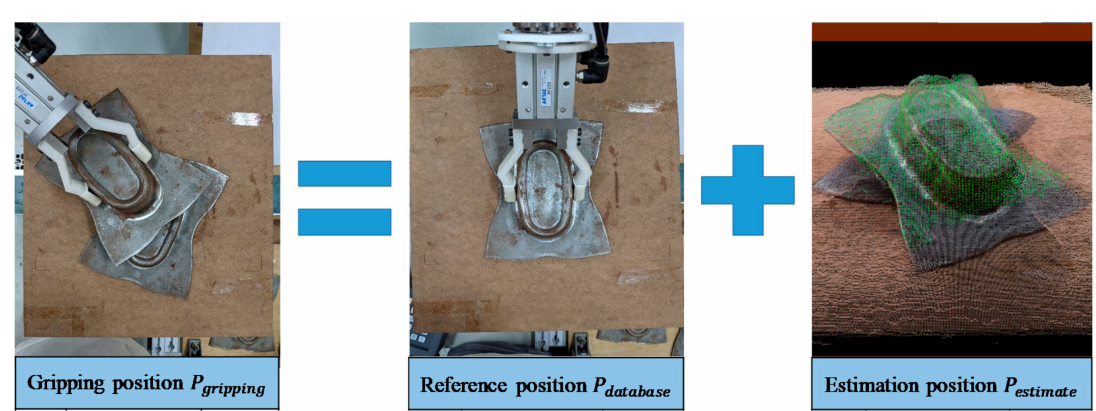
Figure 6. Construction of the target object gripping